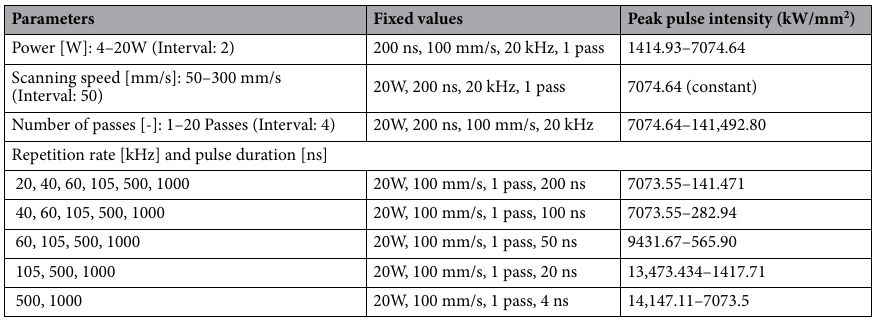
Table 2. Experimental parameters.